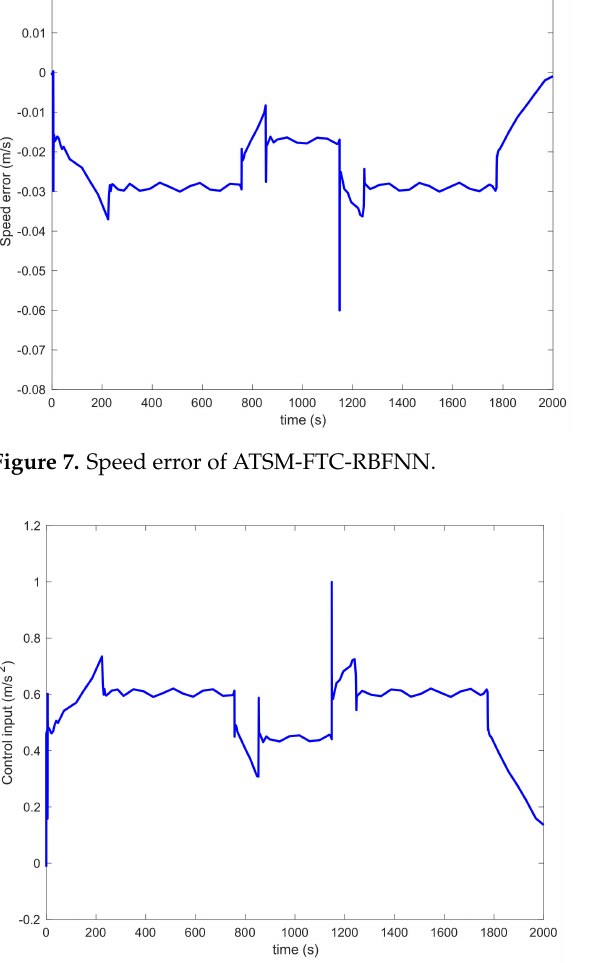
Figure 8. Control input of